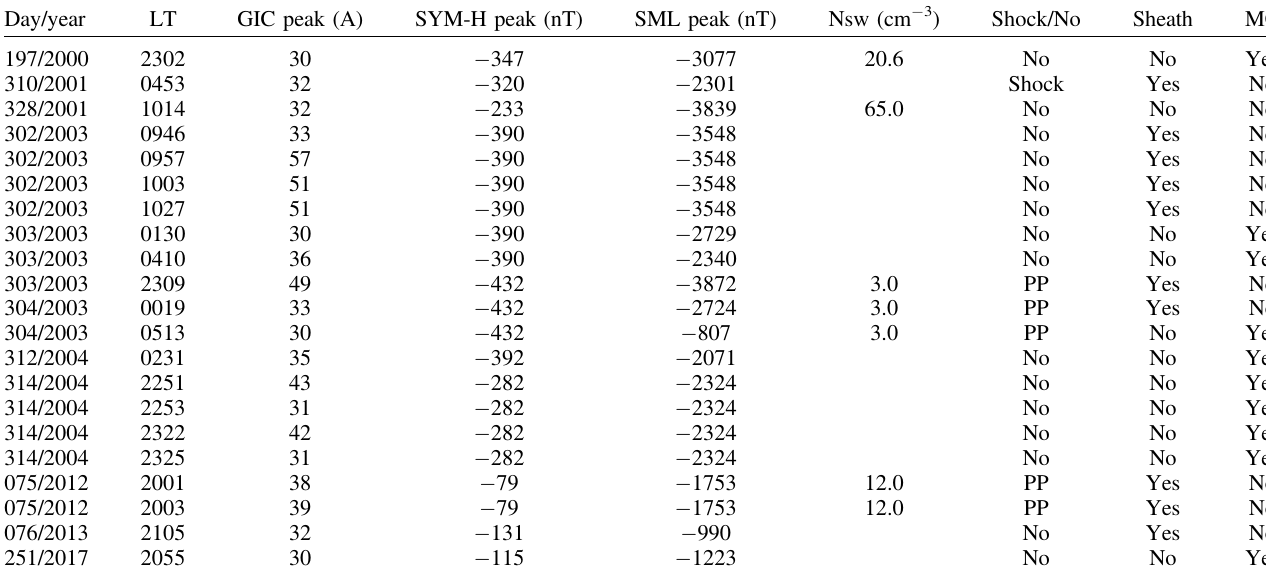
Table 1. Details of the GIC > 30 A events under